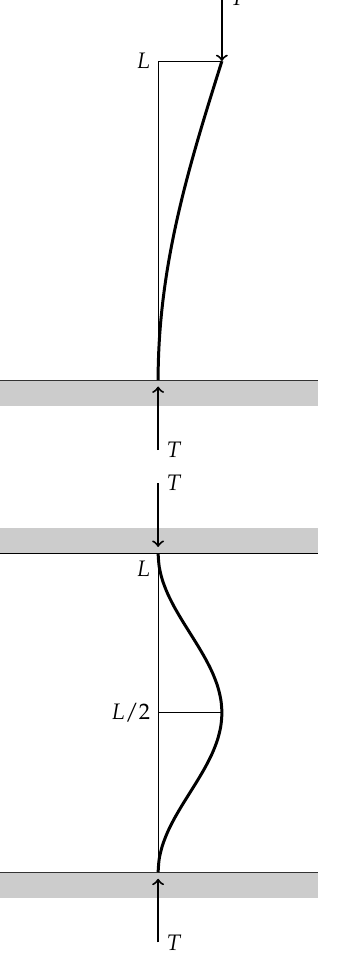
Figure 6. The critical buckling load for a beam under compression (Figure 2) is the same in the linear and non-linear cases of small and large slope, respectively, and depends on the type of support. It is largest for clamping at both ends ( bottom beam ), intermediate if both ends are pinned ( top-right beam ), and smallest for a cantilever beam clamped at one end and free at the other ( top-left beam